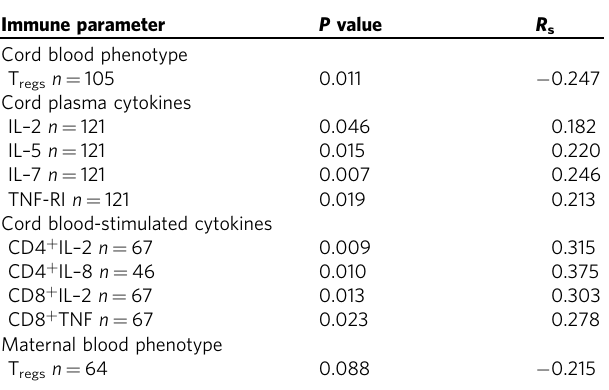
Table 1 Association of immune parameters with maternal bendiocarb level at